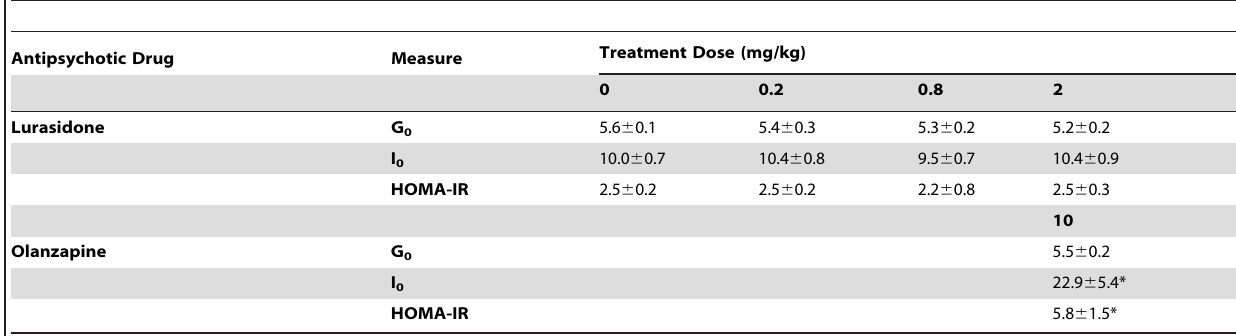
Table 1. Mean concentration of fasting glucose, insulin and HOMA-IR scores in antipsychotic drug treated rats.